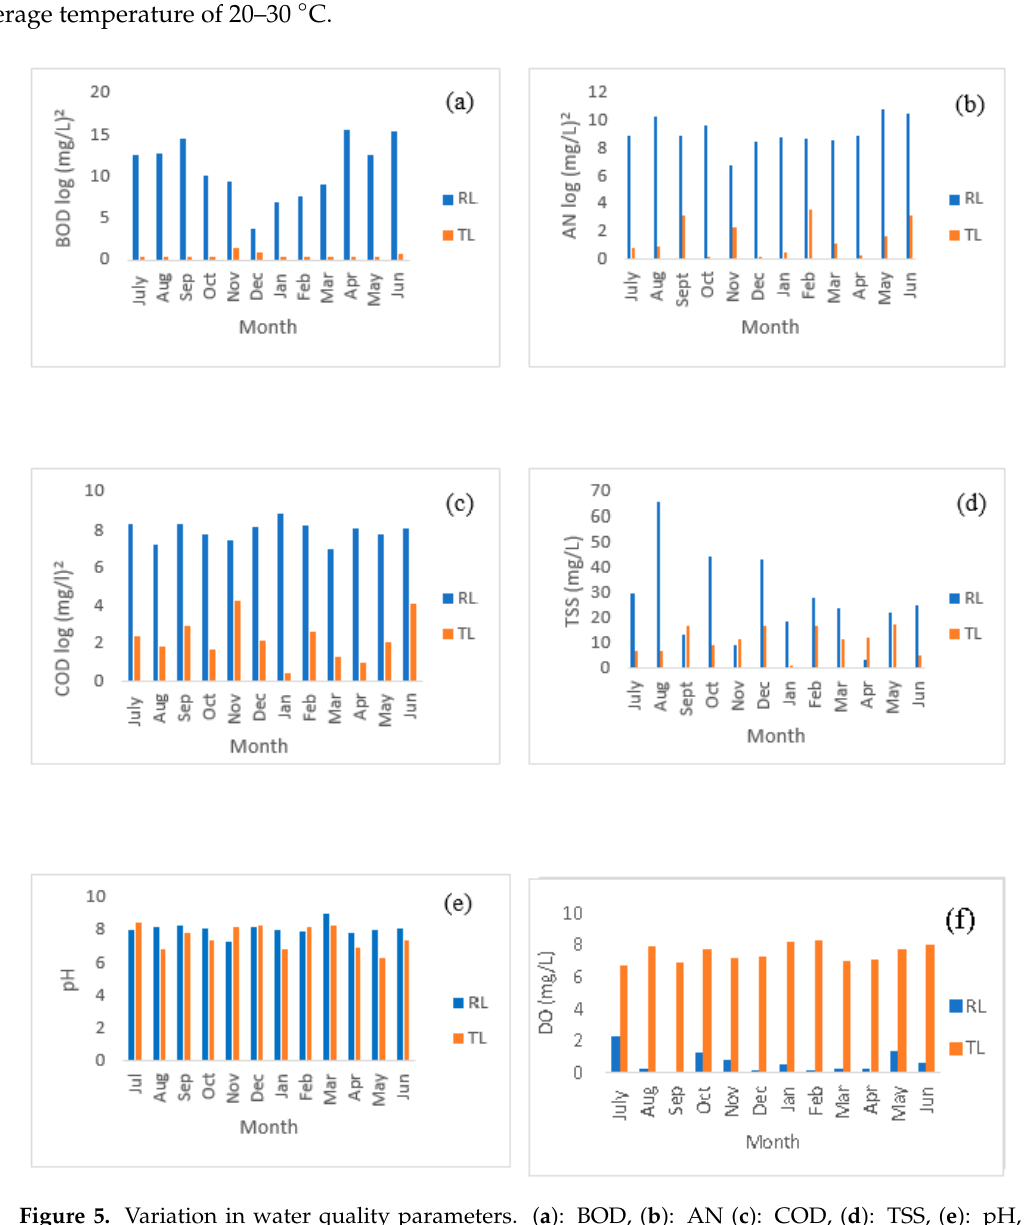
Figure 5. Variation in water quality parameters. ( a ): BOD, ( b ): AN ( c ): COD, ( d ): TSS, ( e ): pH, and ( f ): DO for raw and treated leachate.